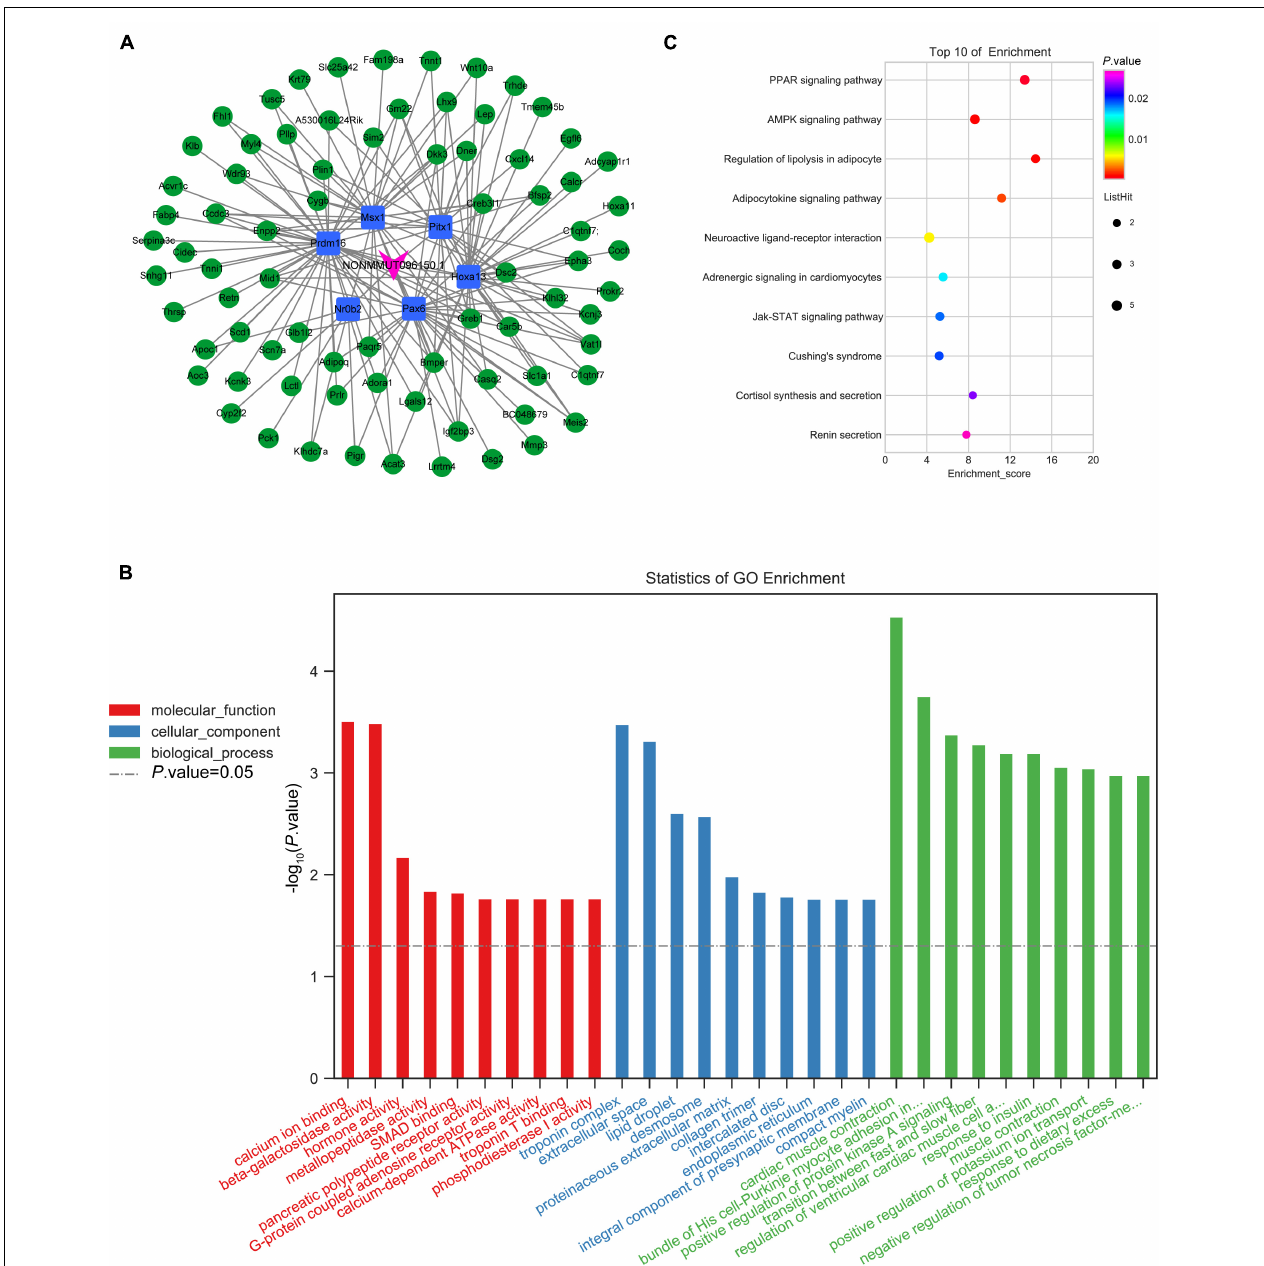
FIGURE 9 | Coexpression network of NONMMUT096150.1-TFs-mRNAs in the OVX mouse model. (A) NONMMUT096150.1-TFs-mRNAs networks in OVX mice. (B) The top 10 GO enrichment analyses of cellular component, molecular function and biological process. (C) KEGG pathway annotations of the network.